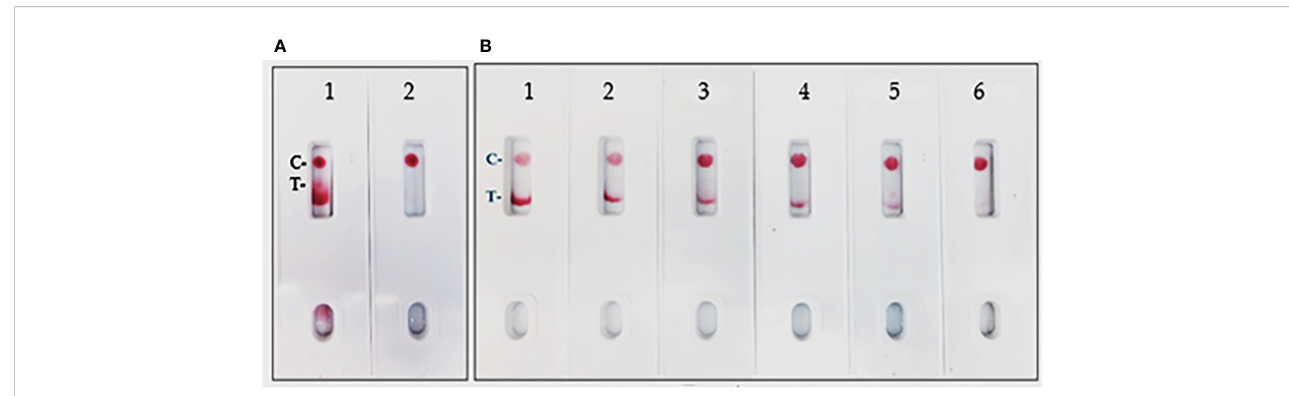
FIGURE 4 (A) LFIA Development with r-Spike protein. 1. NR-52397 SARS-CoV-2 r-Spike protein (200 ng), and 2. NR-53258 Vero E6 cell lysate (negative control). (B) Dose-response curve for LFIA using r-Spike protein. 1. NR-52397 SARS-CoV-2 r-Spike protein (200 ng), 2. 100 ng, 3. 50 ng, 4. 25 ng, 5. 12.5 ng and 6. NR-53258 Vero E6 cell lysate. The LOD for the Spike protein was 25 ng/test in a sample of 150